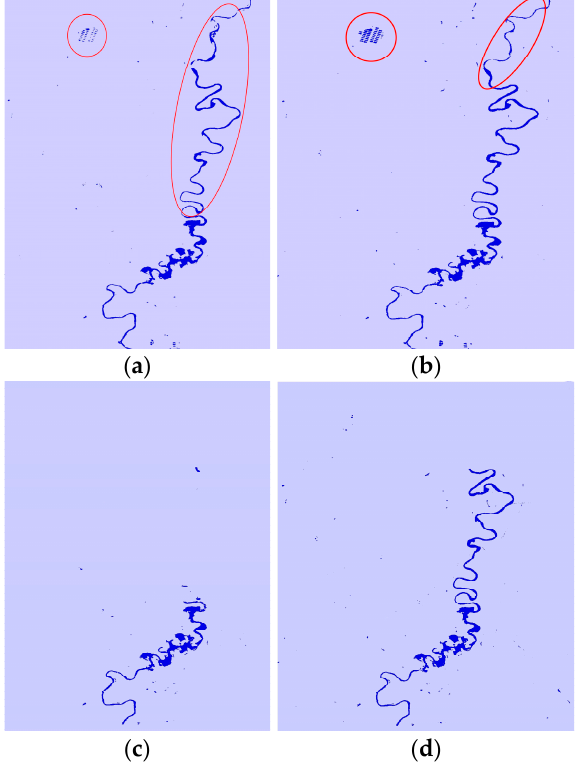
Figure 11. The comparison between MDFM and WatNet. ( a ) Water map using MDFM (with clouds). ( b ) Water map using MDFM (without clouds). ( c ) Water map using WatNet (with clouds). ( d ) Water map using WatNet (without clouds). Table 6. Water extraction accuracy table of WatNet and MDFM.